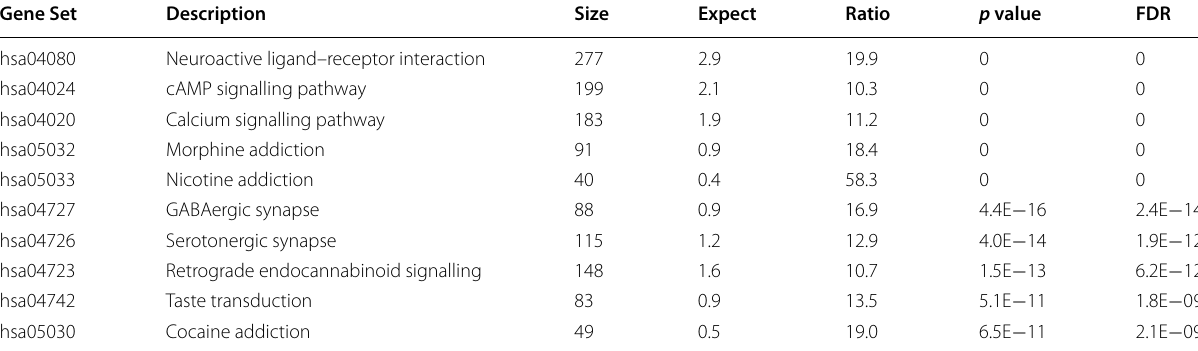
Table 3 Enriched KEGG pathways in target genes of FTD drugs as identified by WebGestalt Gene